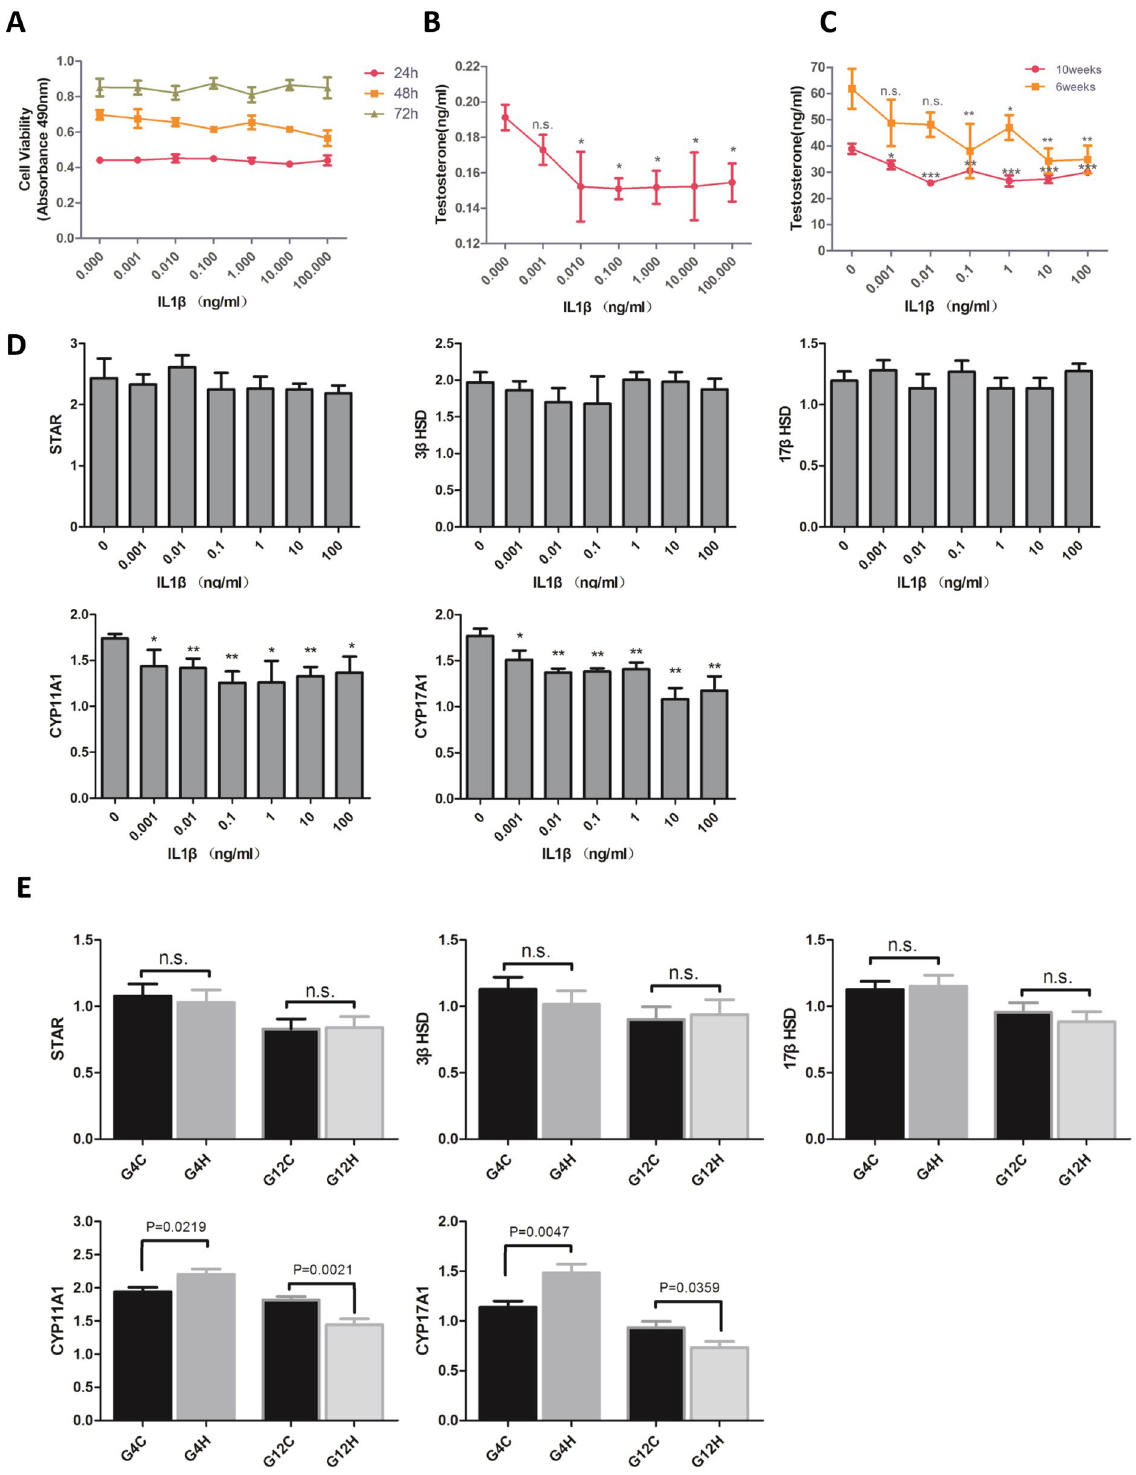
Figure 4. IL1 β inhibits the testosterone synthesis of Leydig cells. ( A ) The TM3 cell number stimulated by different concentrations of IL1 β for 24 h, 48 h and 72 h. ( B ) Testosterone produced by TM3 cells under the stimulation of different concentrations of IL1 β . ( C ) Equal decapsulated testes from 6-week-old mice and 10-week-old mice were incubated with several concentrations of IL1 β for 24 h in vitro . The testosterone of the supernatants was tested using ELISA. ( D ) The mRNA expression of STAR, P450SCC, P45017 α , 3- β HSD and 17 β -HSD in TM3 cells treated with different concentrations of IL1 β for 24 h. The photograph shows a representative result of three independent experiments. ( E ) The mRNA expression of STAR, P450SCC, P45017 α , 3- β HSD and 17 β -HSD in G4H, G4C, G12H and G12C testis. * P < 0.05 and ** P <